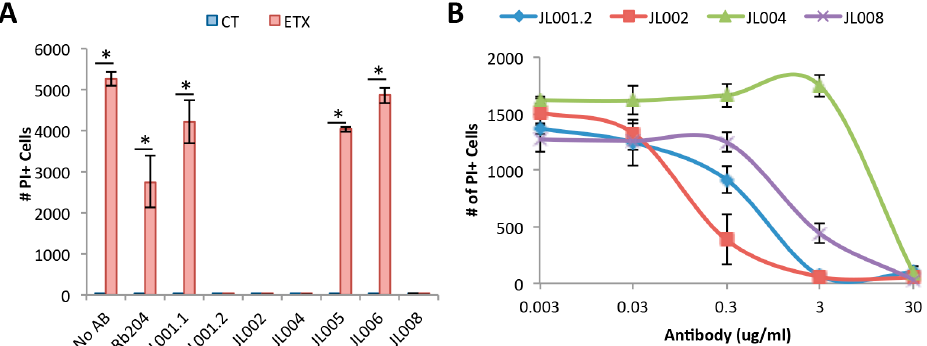
Figure 7. In vitro neutralizing ability of anti-ETX antibodies against ETX. ( A ) Media containing 100 nM of ETX was pre-incubated with the indicated anti-ETX antibodies at 30 μ g/mL for 30 min prior to treatment of rMAL-CHO cells for 1 h. Media containing antibodies alone were used to evaluate possible antibody toxicity to rMAL-CHO cells (CT). Cells treated without antibodies (no AB) were used as controls. Cell death was evaluated by PI exclusion. Antibodies JL001.2, JL002, JL004, and JL008 prevented cell death similar to non-ETX-treated controls. None of the antibodies exhibited cytotoxic effects on rMAL-CHO cells. * p < 0.01 compared to No AB ETX, determined by t -test. ( B ) Media containing 100 nM of ETX were pretreated with indicated doses of anti-ETX antibodies before treating cells for 4 h and evaluating cell death by PI exclusion. Results are mean ± SD with a smooth-fit line.